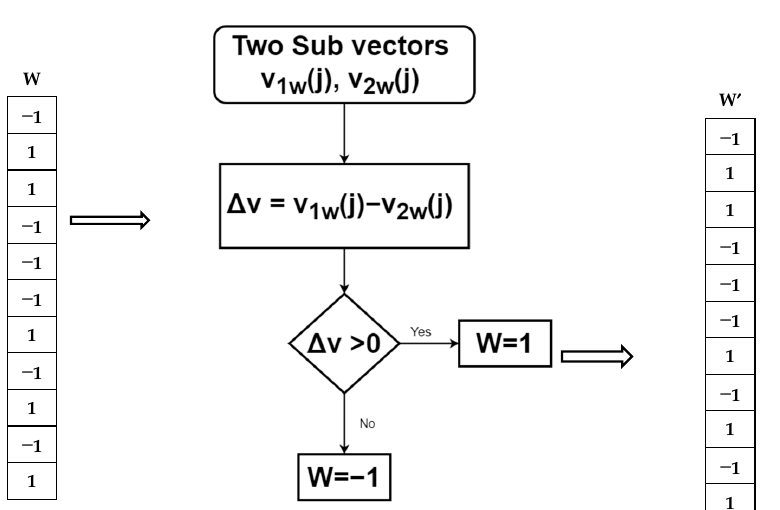
Figure 6. Bit extraction from subtracted values of splitting vectors.